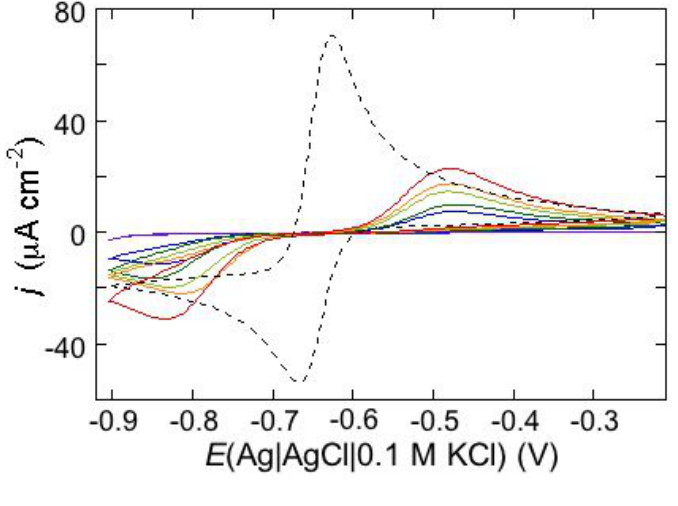
Figure 17. Cyclic voltammograms of 1.5 × 10 − 4 M Cd 2+ in aqueous 0.1 M KCl, recorded on a mercury-supported DOPC SAM at different times t measured from the addition of 0.2 μ M D1. In the order of increasing current, t equals 0, 6, 14, 23, 33, 43 min. The dashed curve is the Cd 2+ cyclic voltammogram recorded on bare mercury. Scan rate: 50 mV s − 1